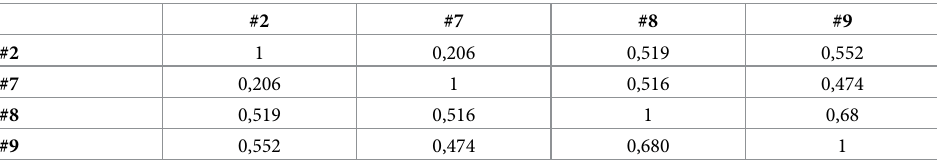
Table 19. Inter-item correlation matrix for subscale 4